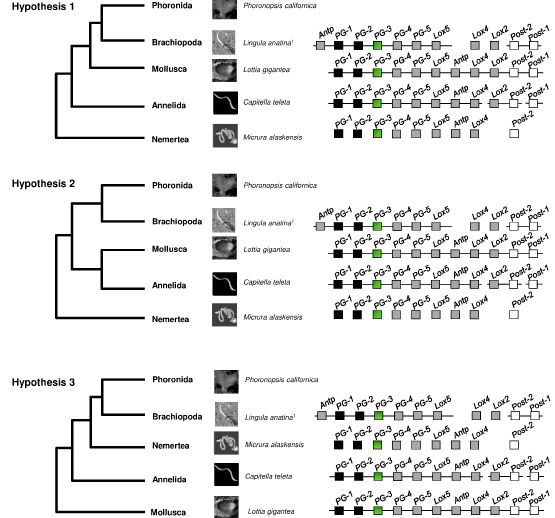
Figure 4. Hypotheses on phylogenetic relationships between the major lophotrochozoan phyla. In the trees displaying the three hypotheses [22], the species in which the largest numbers of Hox genes have been identified are reported for Nemertea and Brachiopoda, for Mollusca Lottia gigantea , the only species showing the intact cluster in Lophotrochozoa, for Annelida Capitella teleta , the species to date showing the least fragmented cluster. Lines underneath boxes indicate syntenic arrangement. Split lines indicate that the cluster is located on different chromosomes or scaffolds. The length of the depicted cluster is not proportional to the effective length in genomes. 1 : in Lingula anatina, Lox4 and Lox2 genes have been identified in de Rosa et al. [16]. Dark boxes indicate genes belonging to the Anterior class; green boxes indicate genes belonging to the Paralog Group 3 ; grey boxes indicate genes belonging to the Central class; white boxes indicate genes belonging to the Posterior class. Gene abbreviations: Antp : Antennapedia ; lab : labial ; Lox2: Lophotrochozoa Hox2 ; Lox4 : Lophotrochozoa Hox4 ; Lox5 : Lophotrochozoa Hox5 ; pb : Proboscipedia ; PG-1: paralog group 1 ; PG-2 : paralog group 2 ; PG-3 : paralog group 3 ; PG-4: paralog group 4 ; and PG-5 : paralog group 5 ; Post-1 : Posterior-1 ; Post-2 : Posterior-2 . The graphics of the figure were modified from Biscotti et al. [94]. For references see Table 1, Tables S1 and